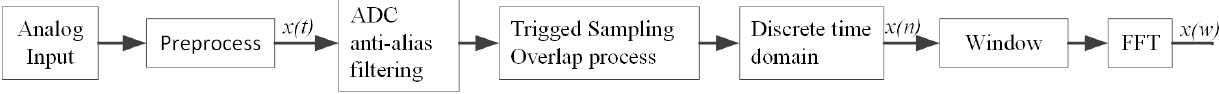
Figure 5. Connection diagram of vibration measurement system.